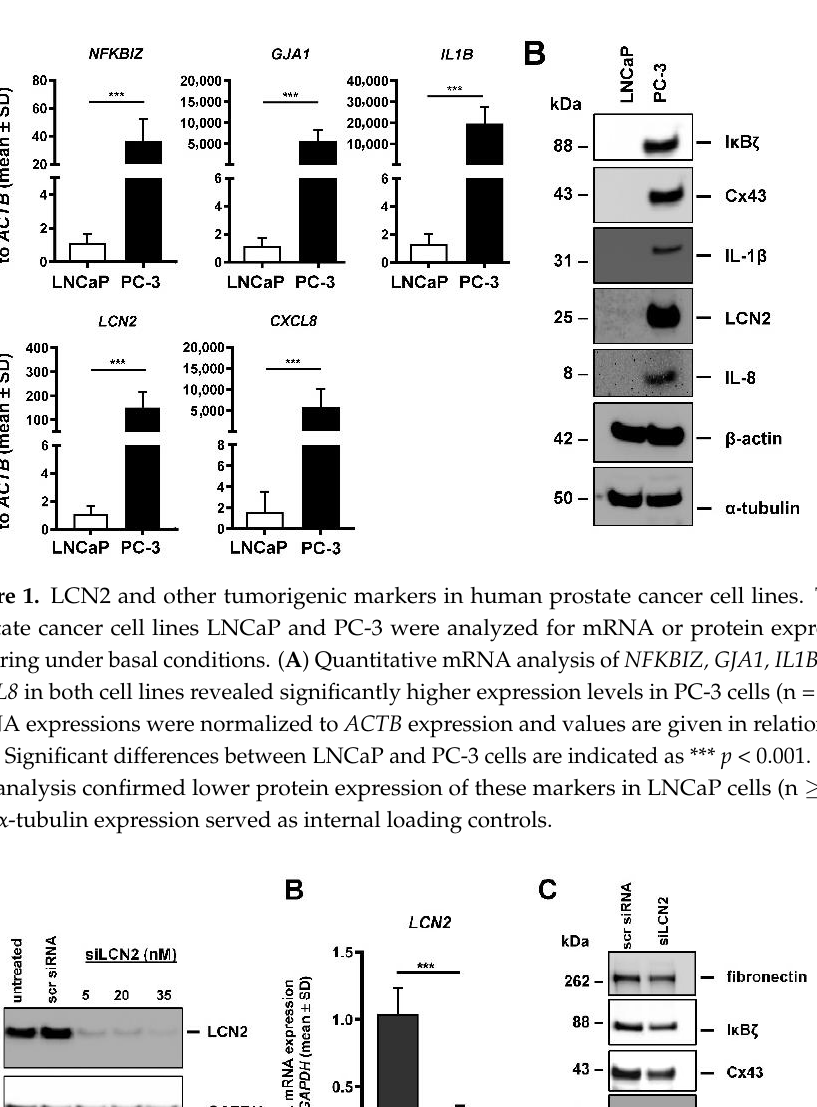
Figure 2. siRNA-mediated knockdown of LCN2 in PC-3 cells. LCN2 expression was analyzed 48 h after transfection of scrambled siRNA (scr siRNA) or indicated concentrations of siLCN2. ( A ) Western blot analysis showed strong reduction in LCN2 protein content (n = 4). GAPDH expression served as a control to demonstrate equal protein loading. ( B ) Quantitative mRNA analysis of LCN2 re- vealed significant reduction in siLCN2 (35 nM) compared to scr siRNA (n = 3; *** p < 0.001). LCN2 mRNA expression was normalized to GAPDH expression and given in relation to scr siRNA-treated cells. ( C ) siRNA-mediated knockdown of LCN2 is associated with reduced protein expression of fi- bronectin, I κ B ζ , Cx43 and IL-1 β as determined by Western blot analysis (n ≥ 3). α -tubulin expression was used to demonstrate equal protein